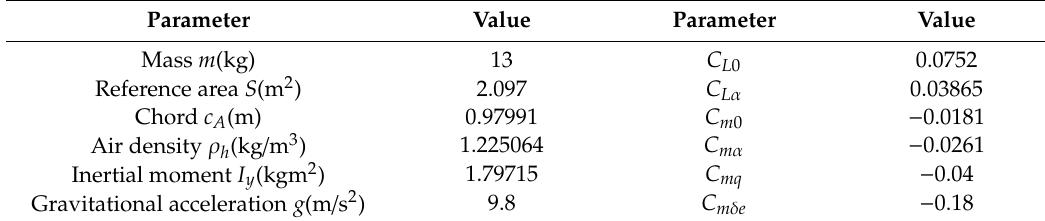
Table 2. Parameters of the saucer-shaped unmanned aerial